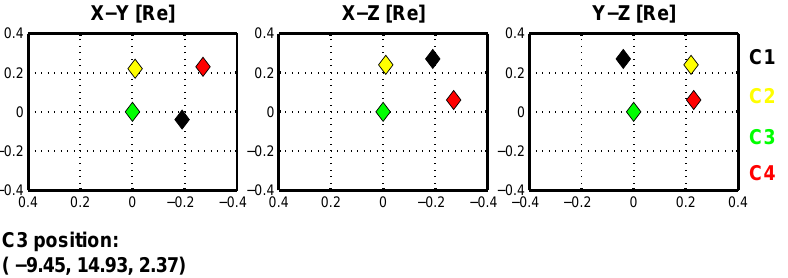
Fig. 18. Locations of Cluster spacecraft at 01:53 UT on 6 November 2001 from the reference spacecraft C3 plotted in XY, XZ and YZ